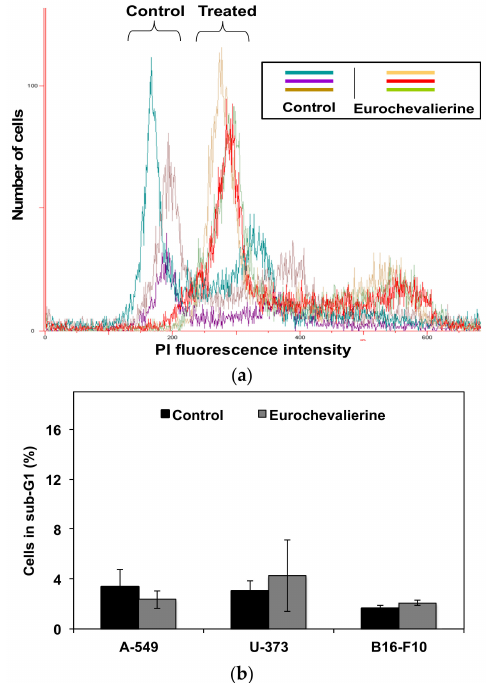
Figure 2. Effect of eurochevalierine on cell cycle distribution. Cells were treated with 50 µ M eurochevalierine for 72 h and then stained with propidium iodide (PI), and DNA content was measured by flow cytometry. ( a ) Cell cycle distribution profile in A-549 cells. Results of three independent experiments are represented on the same graph. ( b ) Quantification of the number of cells in sub-G1 fraction as a percentage of the total cell population. Results are expressed as mean ± SD of at least three independent